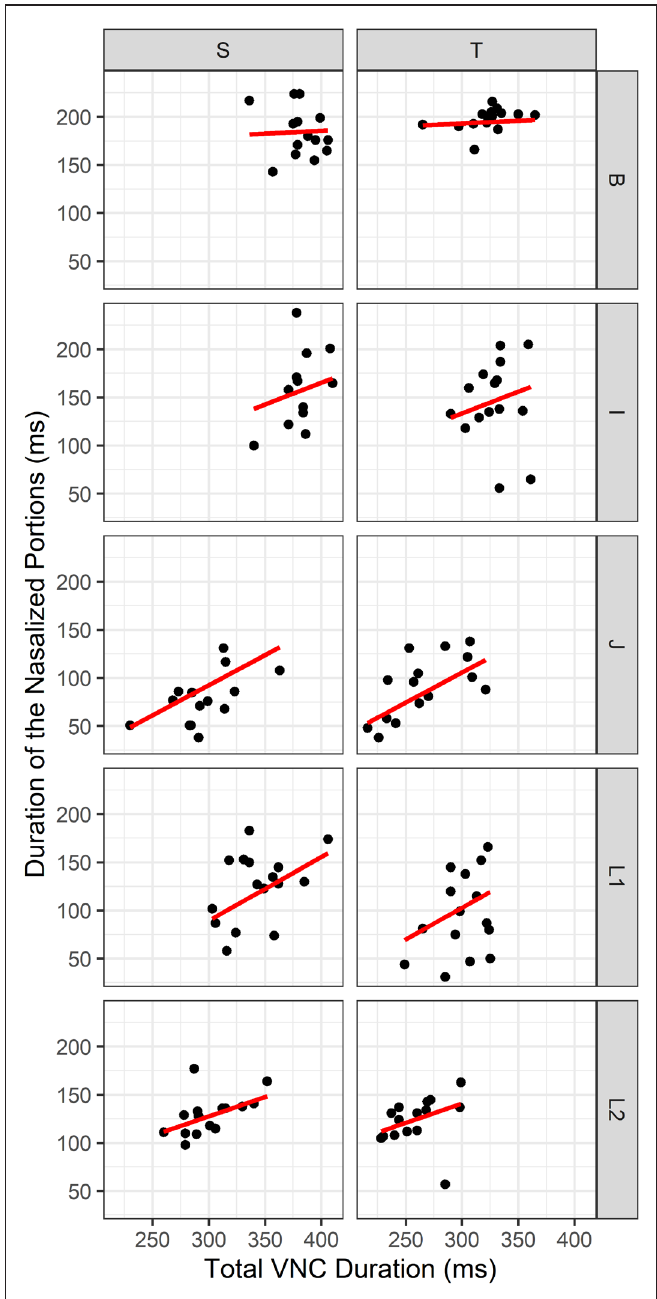
Figure 8: Duration of the nasalized portions (ms) as a function of the total VNC duration (ms) by participant and by context. Red lines represent the results predicted by the